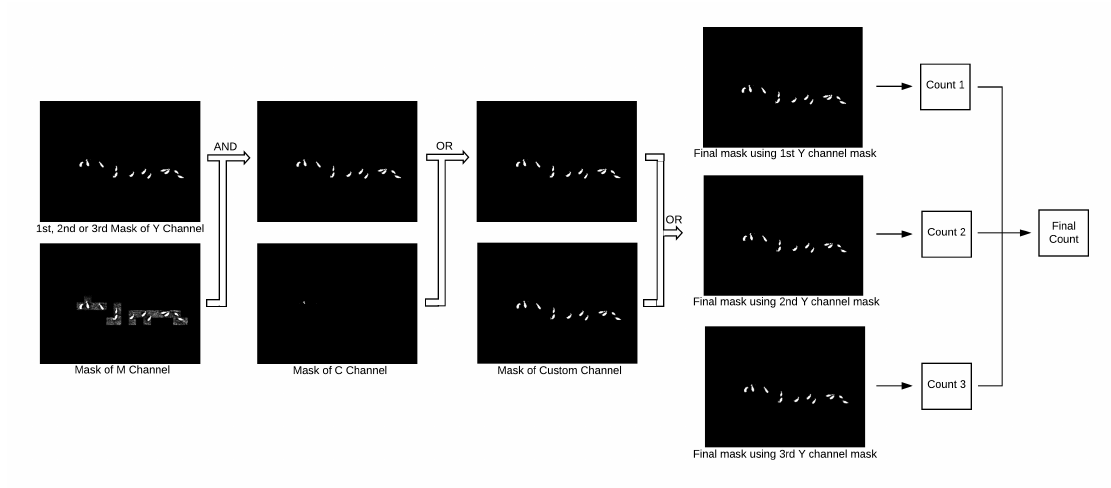
Figure 3. Mask combination and estimation of the number of